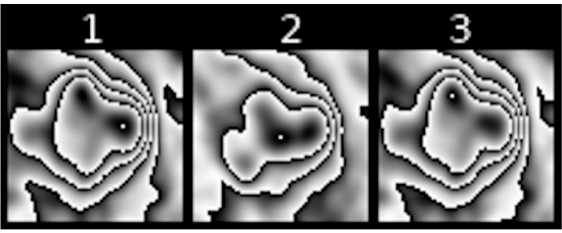
Figure 9. Example of a distinct shift in the location of maximum [18F] FDG uptake in a sequence of PET images of a pulmonary nodule.